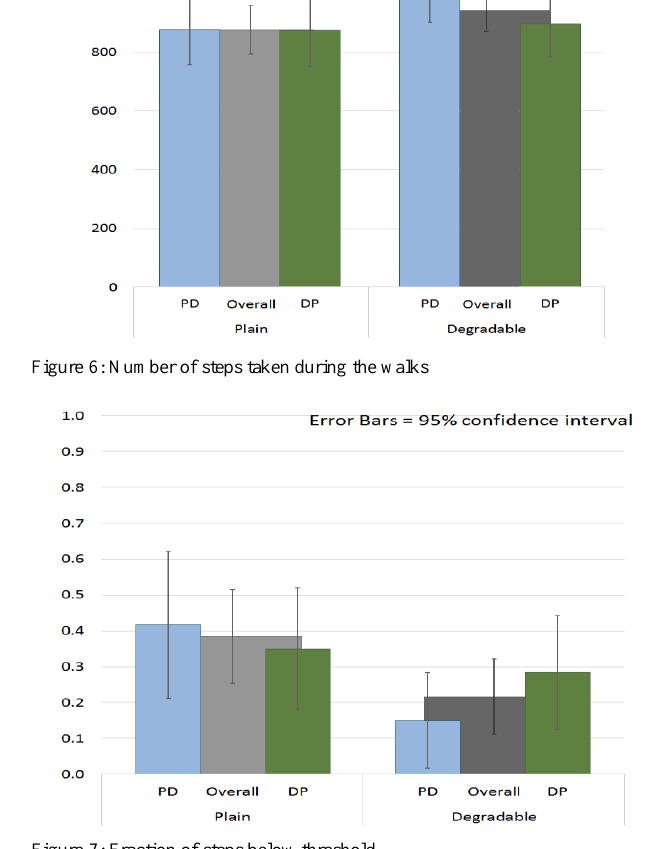
Figure 7: Fraction of steps below